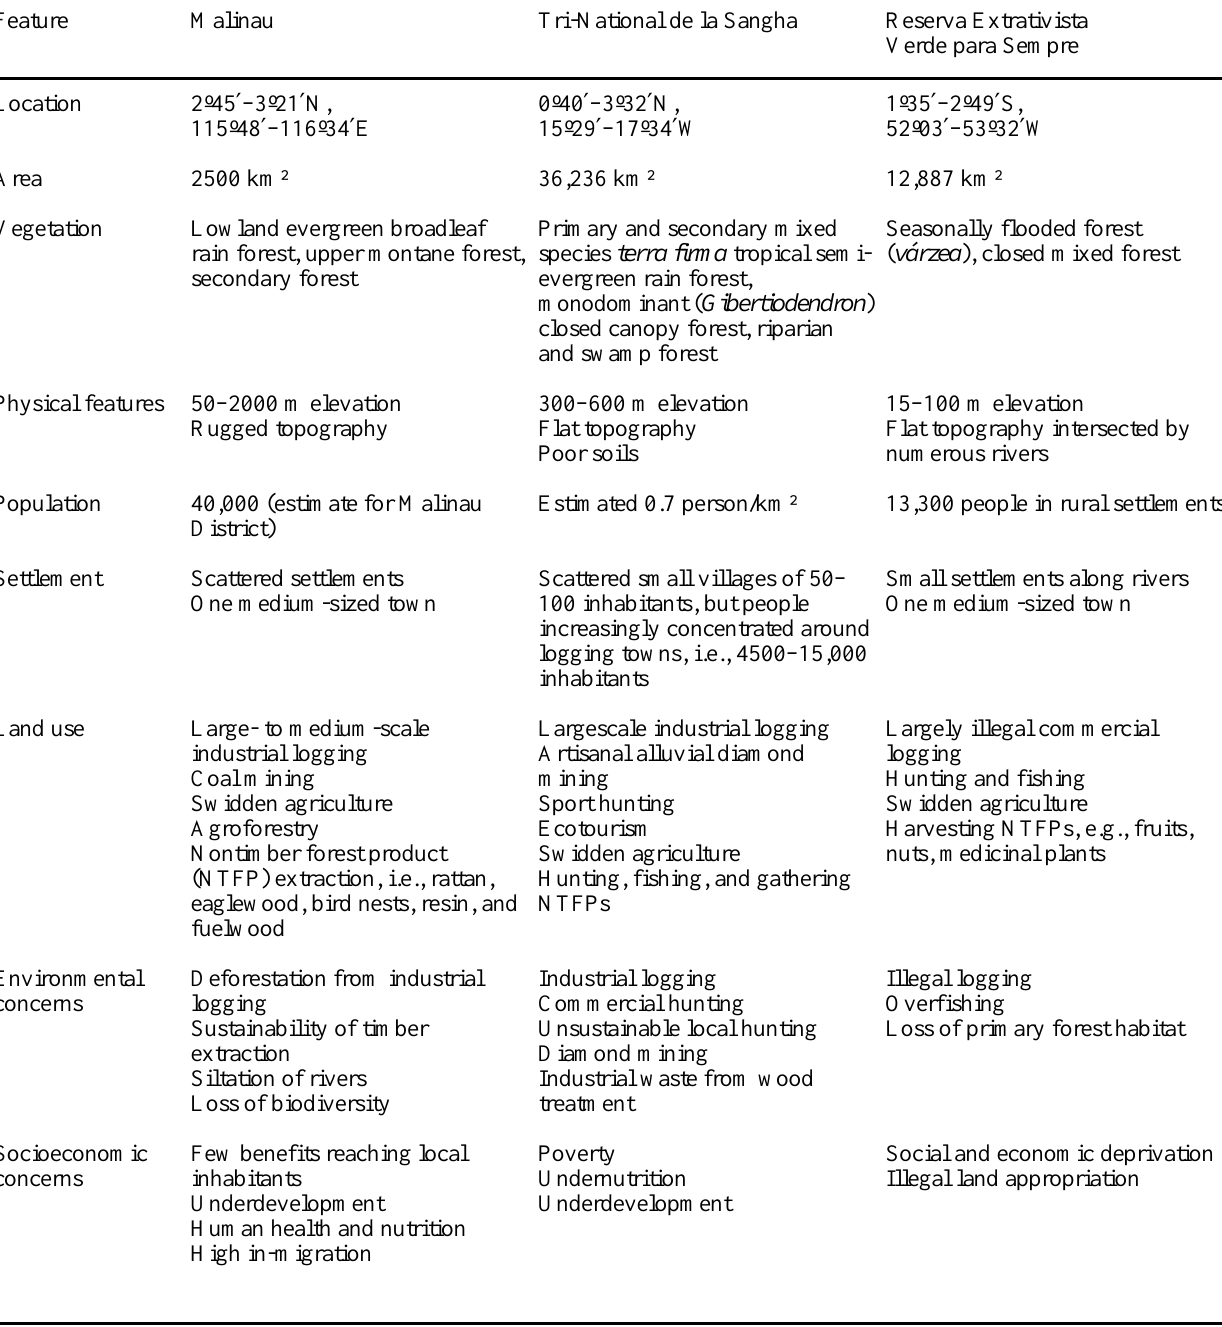
Table 1. Characteristics of three forested regions in which the management of natural resources is being approached in an integrated way, and which illustrate the need for a coordinated and systematic approach exemplified by the integrated natural resource management